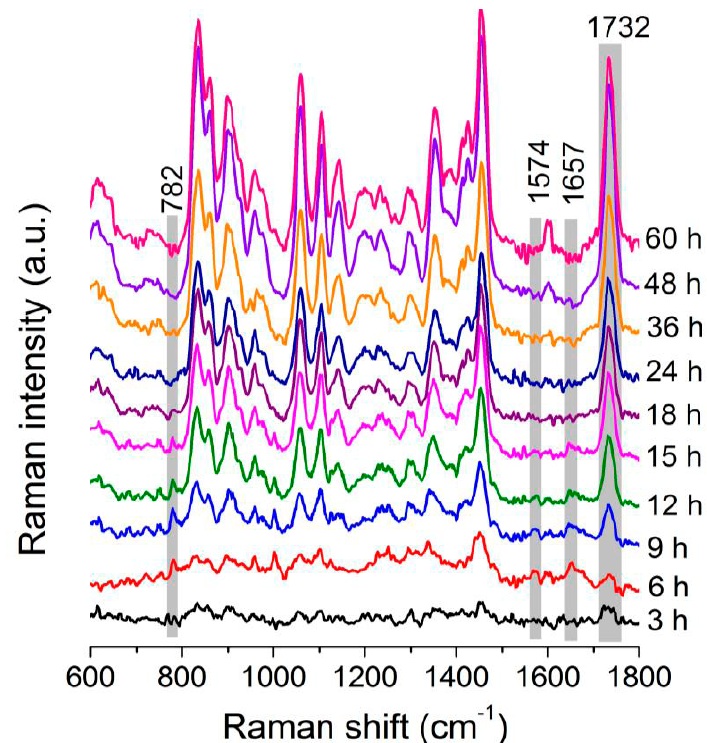
Figure 3. Averaged Raman spectra of single C. necator H16 cells, taken at different incubation times, after subtraction from averaged spectra taken at 0 h.